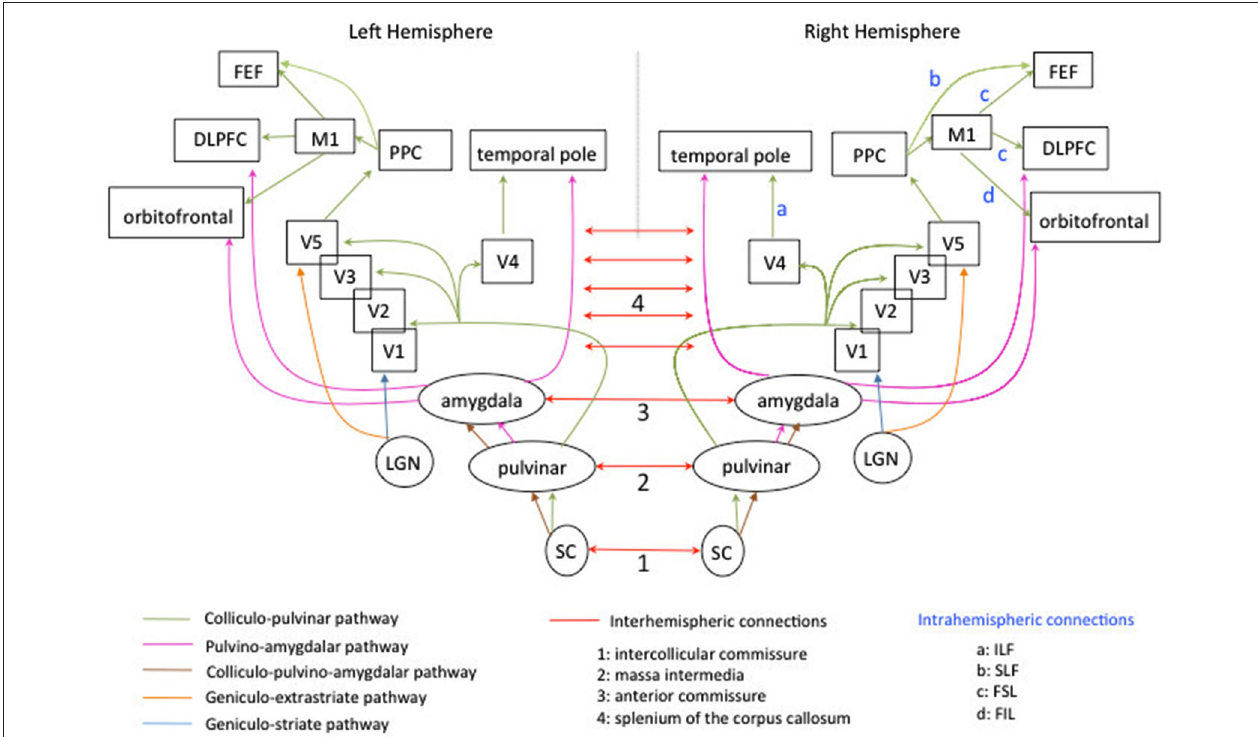
is represented in orange and is symmetrical in the two hemispheres. Only fibers connecting the LGN to area MT+/V5 are represented for clarity of the schema. The geniculostriate pathway is represented in blue and is symmetrical in the two hemispheres. Only fibers connecting the LGN to area V1 are represented. The complexity of cortico-cortical and subcortico-cortical routes is partially represented in Figure 1 . The interhemispheric connections are represented in red. Both SC are connected via the intercollicular commissure (n ◦ 1), both pulvinar via the massa intermedia (n ◦ 2; see Catani and Thiebaut De Schotten, 2012), both amygdala are connected by the anterior commissure (n ◦ 3). Cortical areas in the occipital cortex are connected by the splenium of the corpus callosum (n ◦ 4). Intra-hemispheric connections are labeled by letters in light blue. They are displayed only for the right hemisphere but are also present in the left hemisphere. The pathway linking V4 to temporal pole is the inferior longitudinal fasciculus (ILF: a). The pathway linking the PPC to FEF is the superior longitudinal fascisculus (SLF: b). The pathway linking M1 to FEF and the DLPFC is the superior frontal longitudinal fasciculus (SFL: c). The pathway linking M1 to the orbitofrontal cortex is the inferior frontal longitudinal fasciculus (FIL: